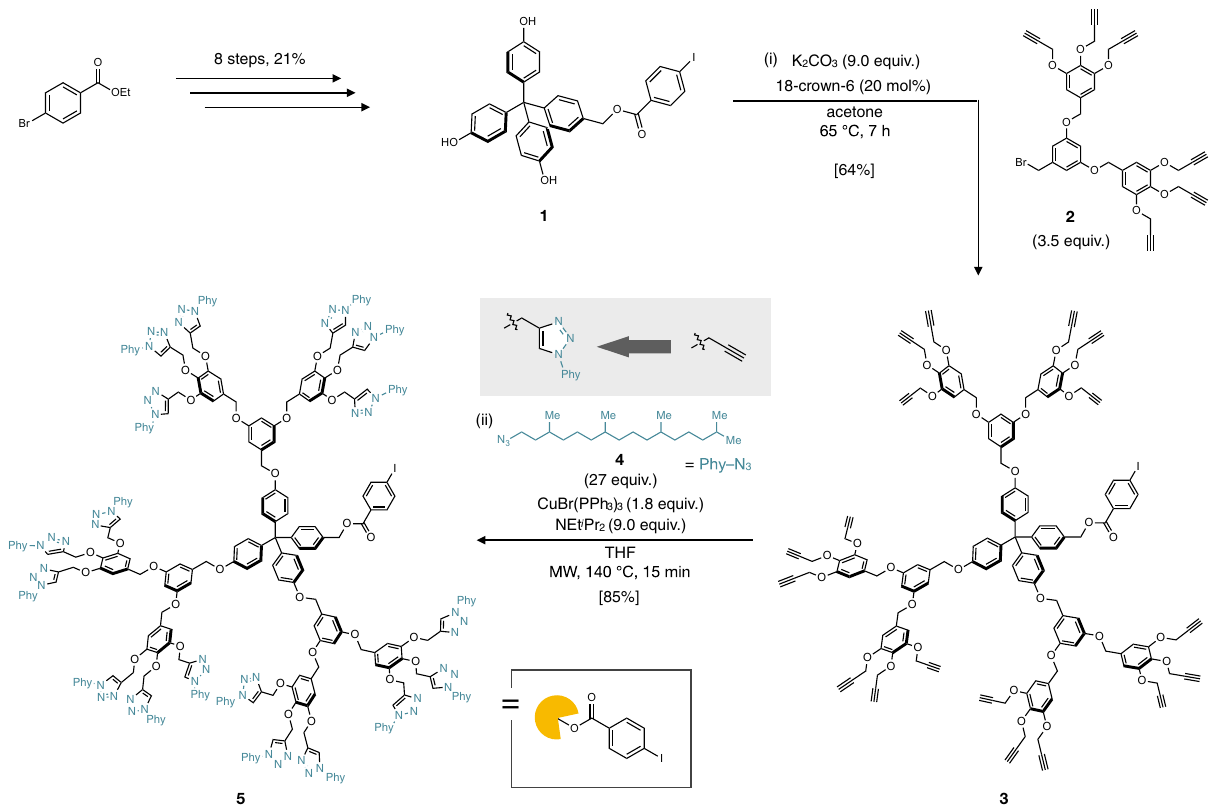
Fig. 2 | Synthesis of dendrimer support. Reagents and conditions: (i) 2 (3.5 equiv.), K 2 CO 3 (9.0 equiv.), 18-crown-6 (20mol%), acetone, 65°C, 7h; (ii) 4 (27 equiv.),